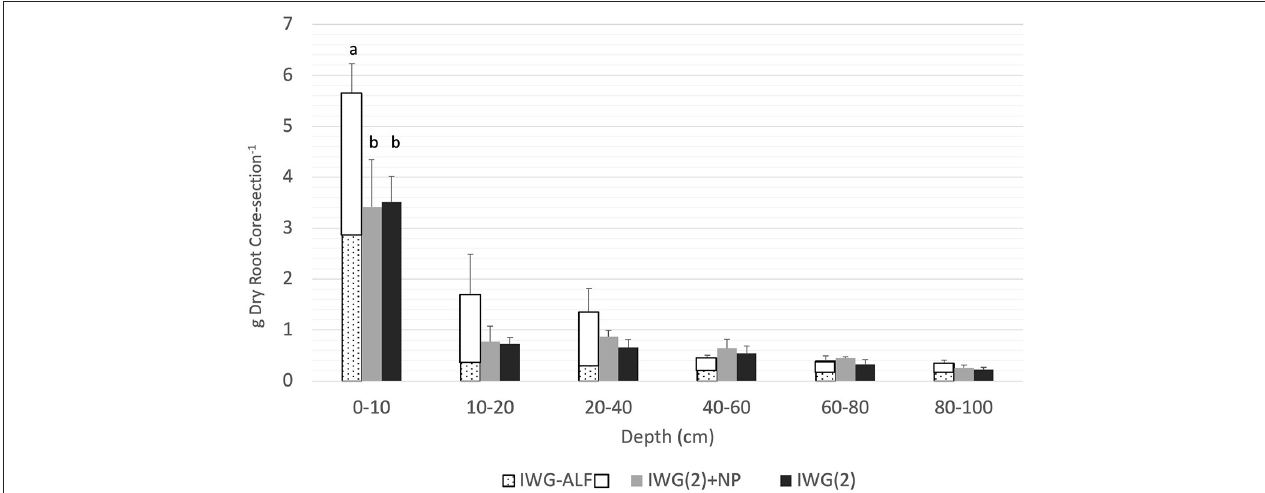
FIGURE 7 | Mean total root biomass (coarse + fine roots) sieved from two 1m cores (diameter 6.2cm) per plot in 2015. In the IWG(2) + NP treatment (gray bar) and the IWG(2) treatment (black bar) 1 core was sampled from 2 separate rows. In the IWG-ALF treatment, 1 core was sampled from an alfalfa row (white) and one core sampled from an intermediate wheatgrass row (speckled). In all cases cores were taken from between plants. Cores were divided into six strata. Bars with different lowercase letters indicate significant differences within a depth at p < 0.05 (Tukey HSD). Bars = 1S.E.